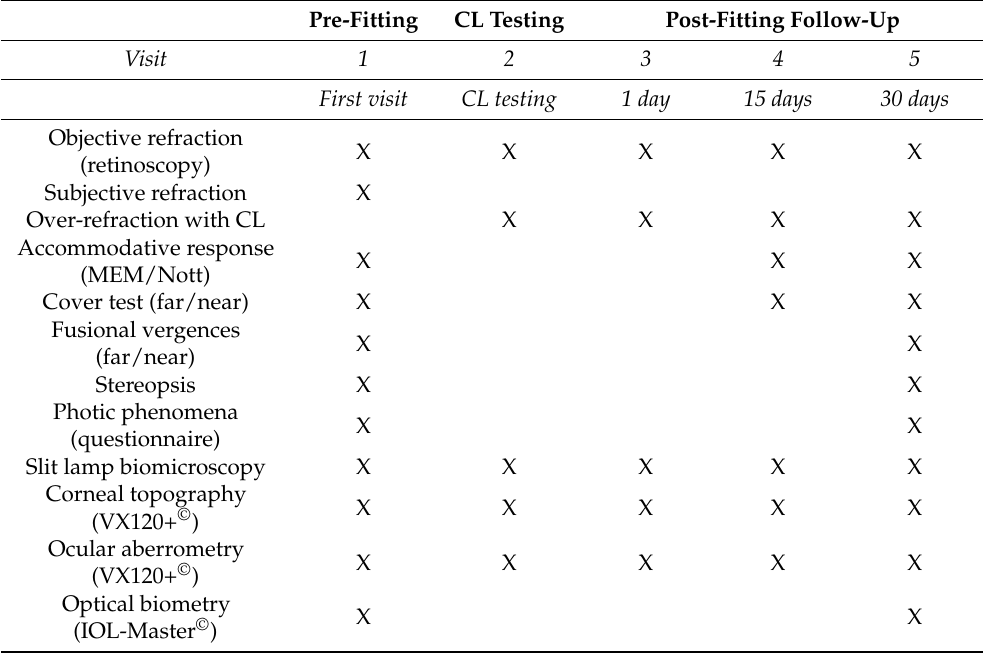
Table 1. Clinical protocol followed in the current study. Abbreviations: CL, contact lens; MEM, monocular estimation method. Abbreviations: CL, contact lens; MEM, monocular estimation